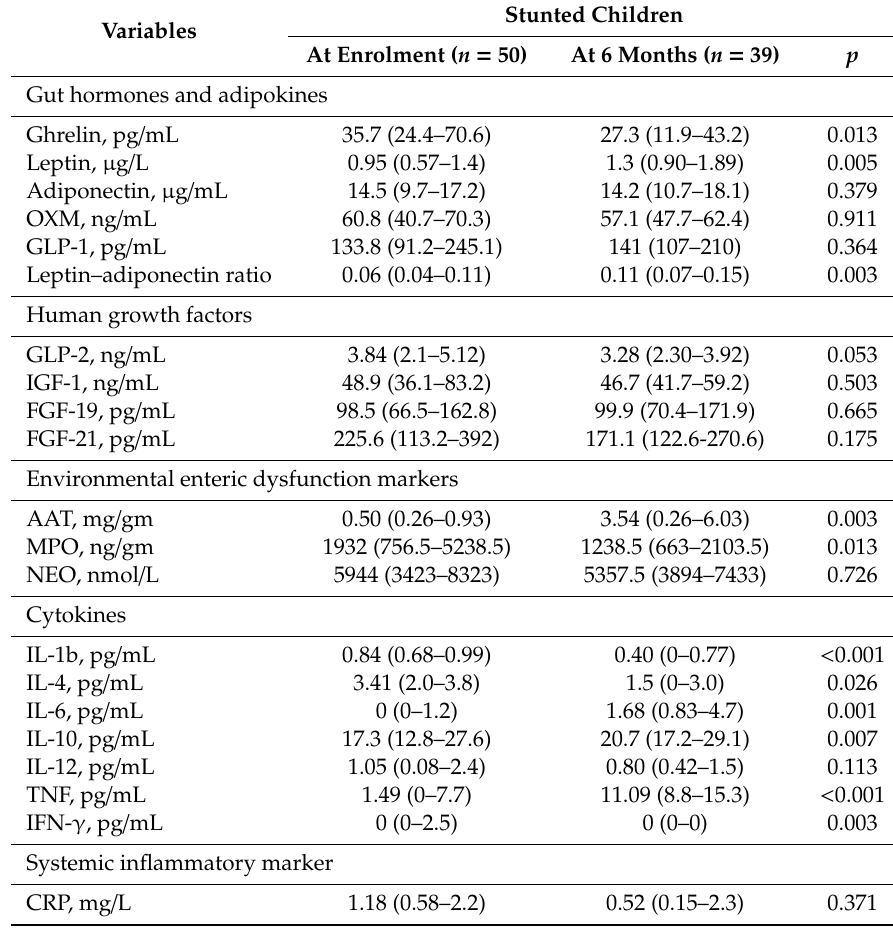
Table 4. Changes in di ff erent biomarkers among stunted children over